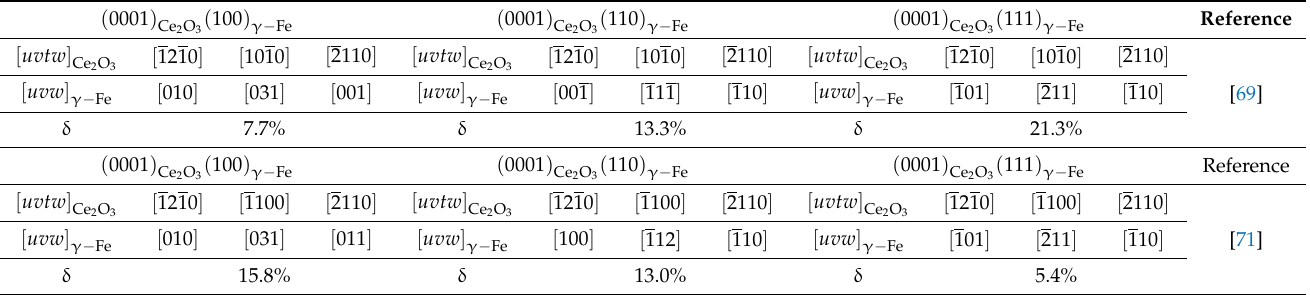
Table 3. Planar misfits between Ce 2 O 3 , Ce 2 O 2 S, La 2 O 3 , La 2 O 2 S, CeS, and γ